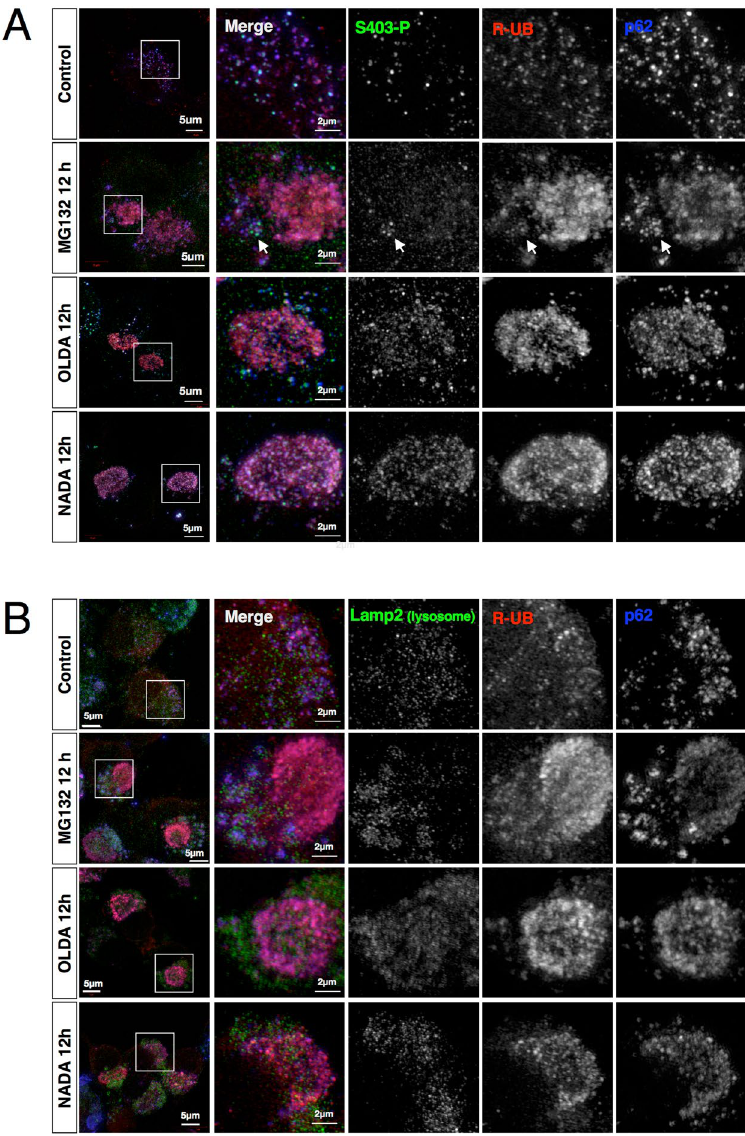
Figure 4. Super-resolution microscopy (SR-SIM) revealed that the aggresome consists of p62 bodies containing p62 and ubiquitinated proteins. N2a cells stably expressing RFP-fused ubiquitin (R-UB) were treated with 1 µ M MG132, 5 µ M OLDA, or 5 µ M NADA for 12 h as indicated. S403-phosphorylated p62 (S403-P; green) in ( A ), Lamp2A (lysosome; green) in ( B ), RFP-UB (red), and total p62 (blue) in ( A,B ) were visualized by super- resolution structured illumination microscopy (SR-SIM) as indicated. Magnified images in square box (10 µ m each side) on left panels are shown. Scale bars represent 5 µ m in wide images or 2 µ m in magnified images as